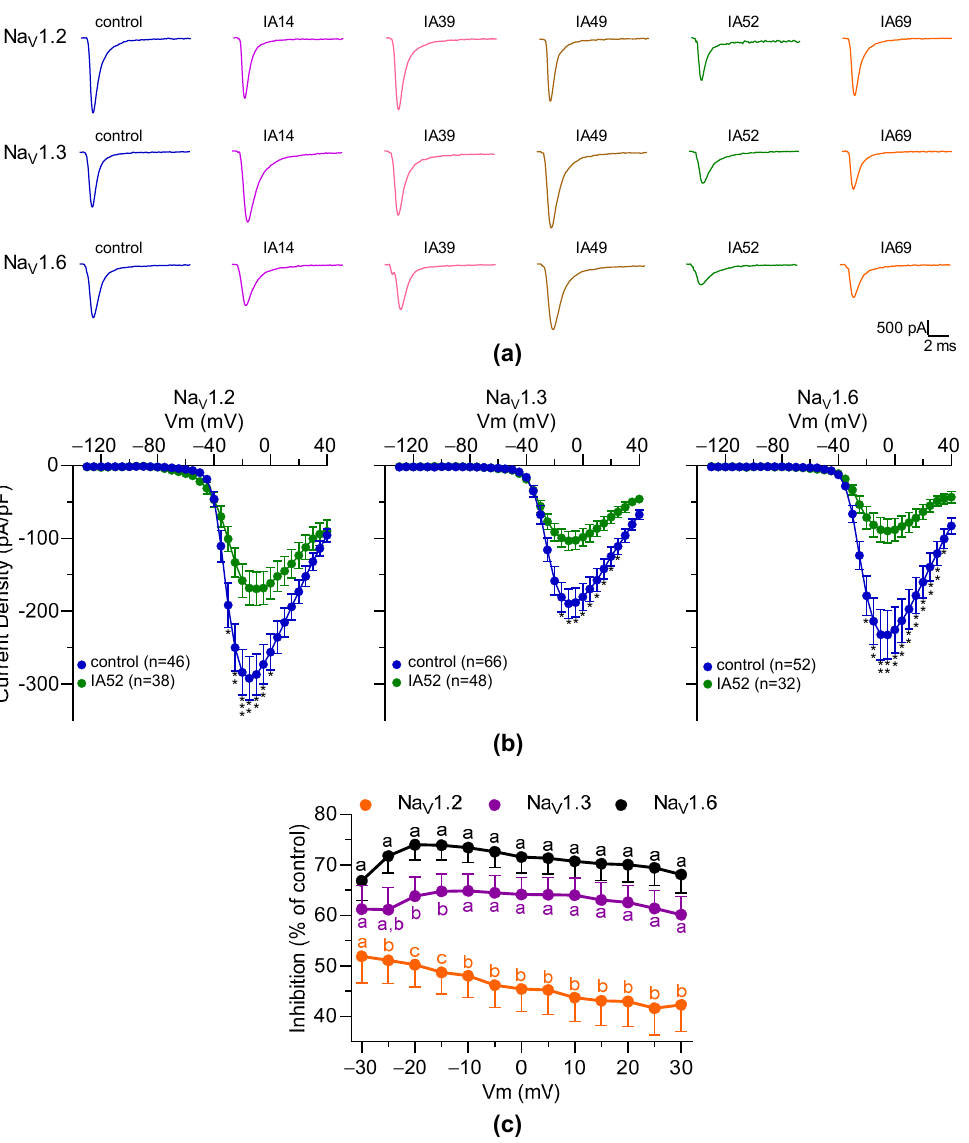
30 mV, bebeerine had stronger inhibitory effects on the hNa V 1.3 (60–64%, n = 38) and hNa V 1.6 channels (70–74%, n = 32) than on the hNa V 1.2 channel (42–50%, n = 38, Figure 7c). Notably, bebeerine significantly inhibited the hNa V 1.6 channel to a higher extent (74 ± 3%, n = 32) than the hNa V 1.3 channel (64 ± 4%, n = 48; p < 0.05), at − 20 mV and − 15 mV, respectively (Figure 7c). Altogether, these data show that bebeerine efficiently blocked the hNa V 1.2, hNa V 1.3, and hNa V 1.6 channels, with the following rank order: hNa V 1.6 > hNa V 1.3 > hNa V 1.2.